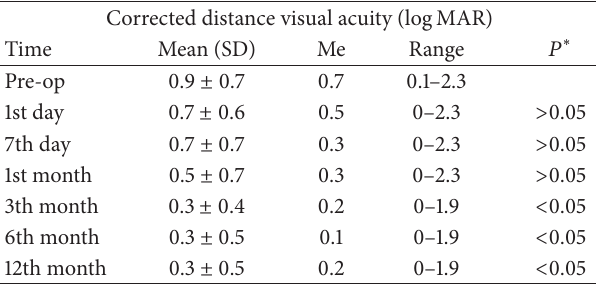
Table 3: Mean values, median number, standard deviations, ranges of corrected distance visual acuity at specific times after